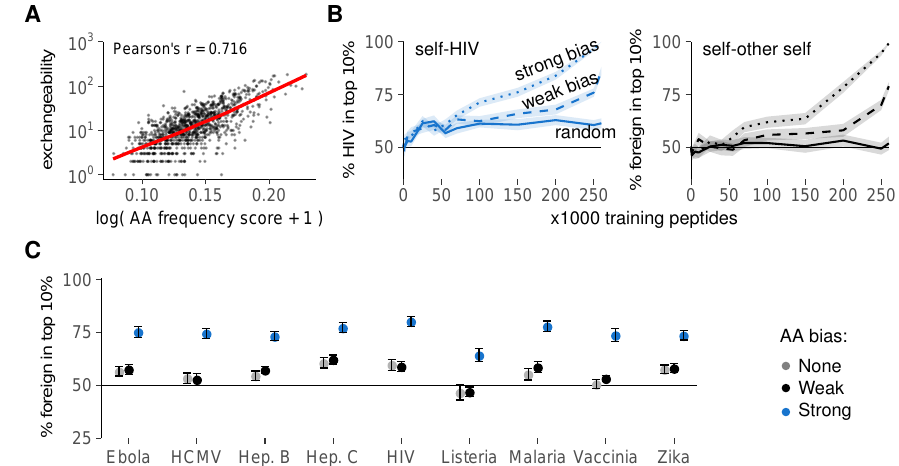
Figure 7. Thymic enrichment for rare AAs facilitates self-foreign discrimination by improving self representation during negative selection. ( A ) exchangeability versus peptide AA frequency score in a random sample of 1000 self peptides (frequency score is low for peptides with many rare AAs (detailed methods in Appendix A)). Pearson’s correlation coefficient r = 0.716, with 95% confidence interval [0.684, 0.745]. See also Figure S5; ( B ) discrimination after negative selection on self peptides chosen with a (weak/strong) bias for rare AAs. Discrimination after selection on random peptides (Figure 5D) is included for comparison. Plots show self-HIV discrimination (left), and self-other self discrimination (right, where a random sample of self was assigned the label “foreign” before selection on training sets from the remaining “self” peptides); ( C ) self-foreign discrimination for different pathogens after negative selection on 150,000 self peptides chosen randomly or with AA bias. See Figure S6 for the full discrimination curves. Negative selection in panels b and c was performed with t = 4, and results were plotted as mean ± SEM of 30